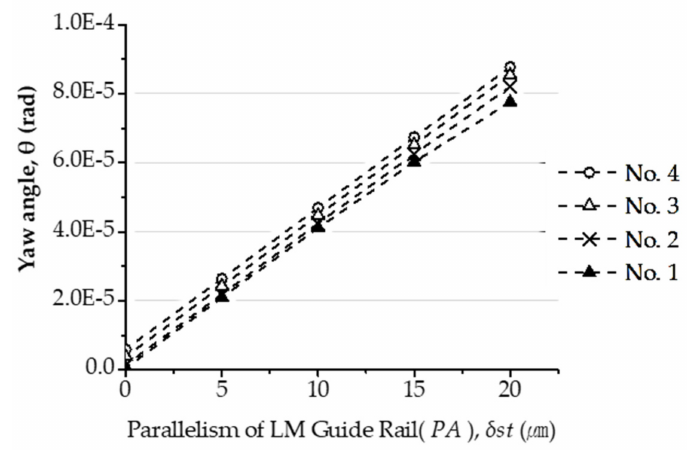
Figure 16. Results of the yaw angle of platforms.